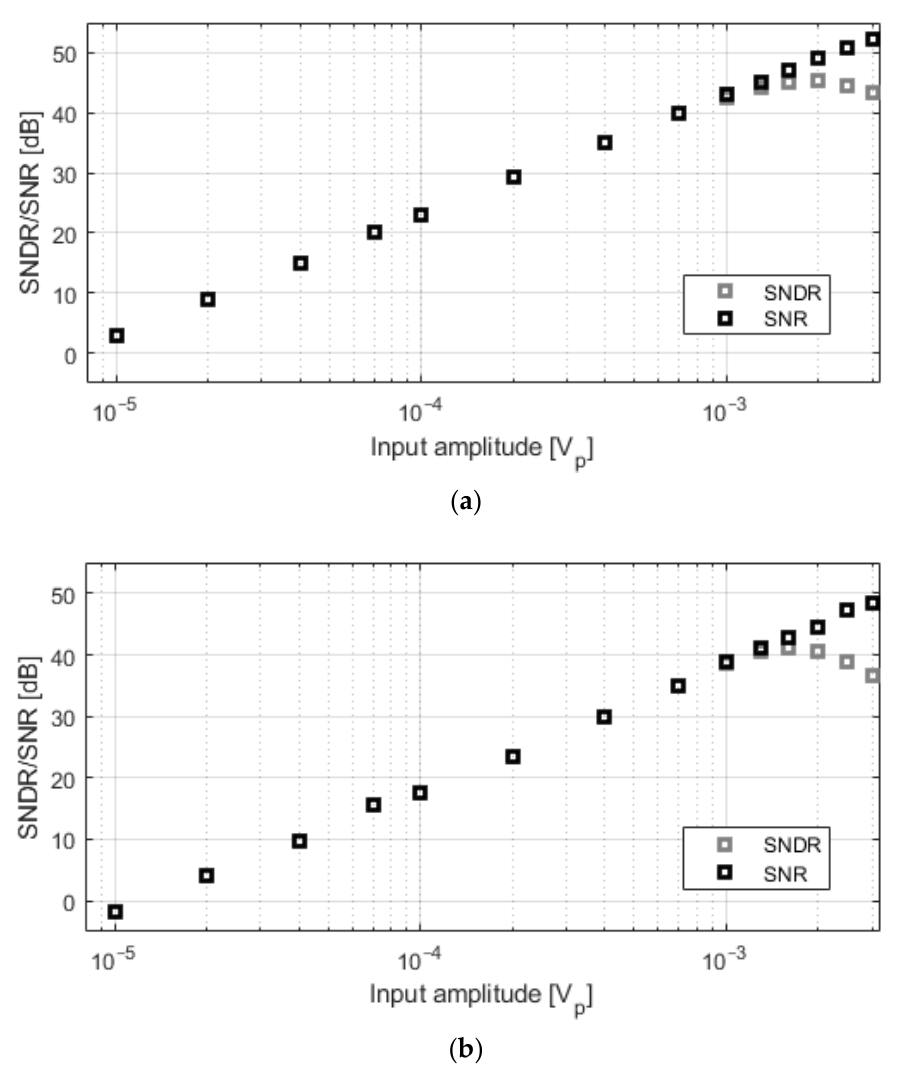
Figure 9. Measured SNDR and SNR for different input amplitudes at 1 kHz. ( a ) C 0 = 350 fF; ( b ) C 0 = Figure 9. MeasuredSNDRandSNRfordifferentinputamplitudesat1kHz. ( a )C 0 =350fF;( b ) C 0 = 4.25 4.25 pF.